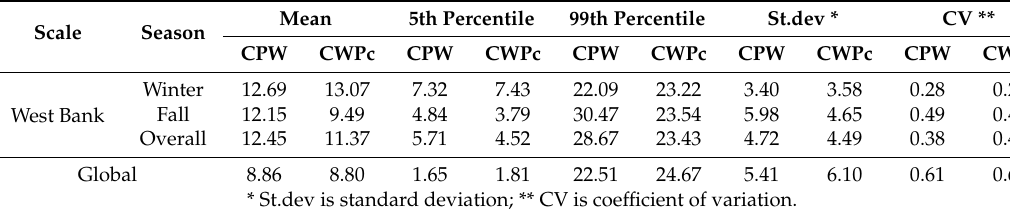
Figure 4. ( a ) Density of potato fresh tuber CWP (kg m − 3 ), ( b ) density of potato fresh tuber CWPc (kg m − 3 ), ( c ) CWP (kg m − 3 ) plotted against yield and ( d ) CWPc (kg m − 3 ) plotted against yield. Each plot shows the winter (2014 winter rotation) and the fall (2015 fall rotation) rotations in the West Bank, Palestine, as estimated in SEBAL, and global values of CWP (global) taken from literature (Appendix A). Table 4. Potato fresh tuber CWP (kg m − 3 ) and CWPc (kg m − 3 ) statistics in the West Bank, Palestine, as estimated in SEBAL, and global values of CWP taken from literature (Appendix A).